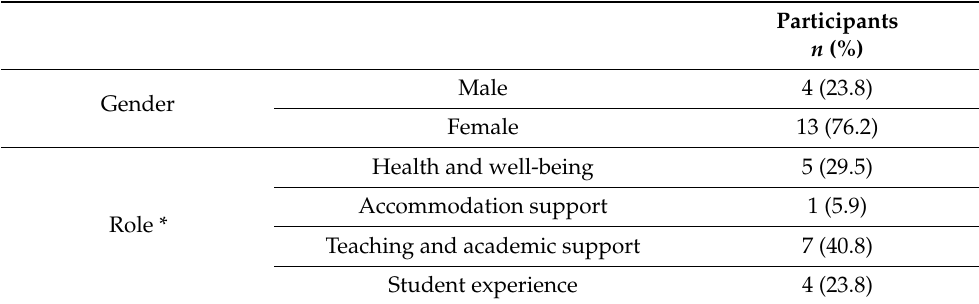
Table 2. Characteristics of university staff members ( n = 17).